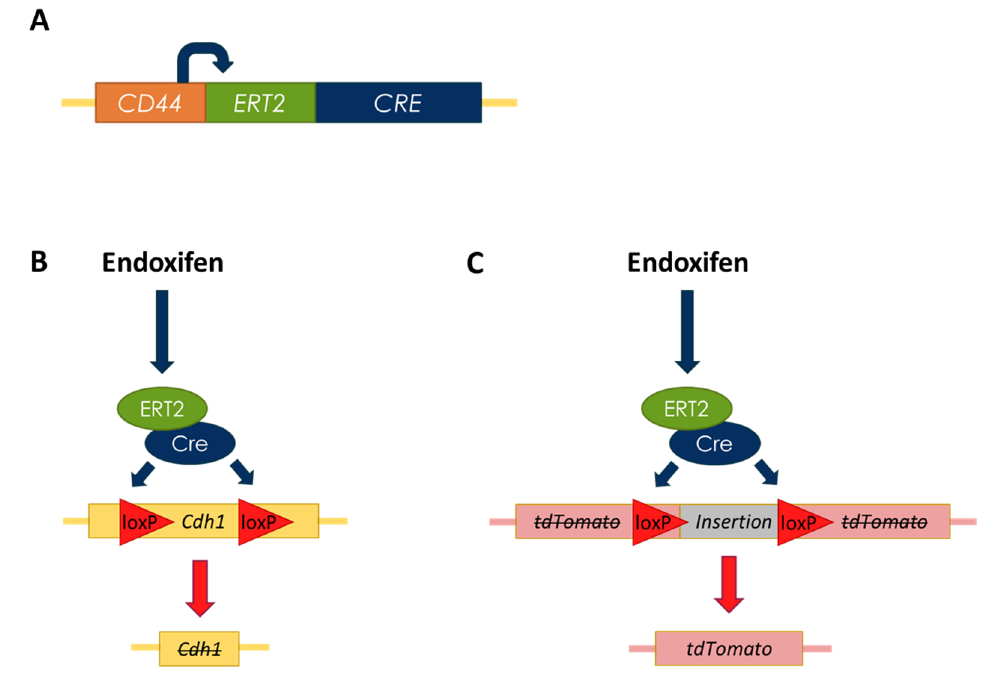
Figure 6. Schematic of transgenic mouse constructs. ( A ) The CD44 promoter drives expression of a Cre recombinase-ERT2 fusion protein. ( B ) Endoxifen treatment causes the fusion protein to localise to the nucleus. Cre recombinase recognises two loxP sites flanking exons 6 to 10 of the Cdh1 gene, and excises this region through Cre-mediated recombination, effectively deactivating Cdh1 . ( C ) Induction of the fusion protein also excises a premature stop codon inserted into a tdTomato construct, inducing expression of the red fluorescent protein tdTomato.